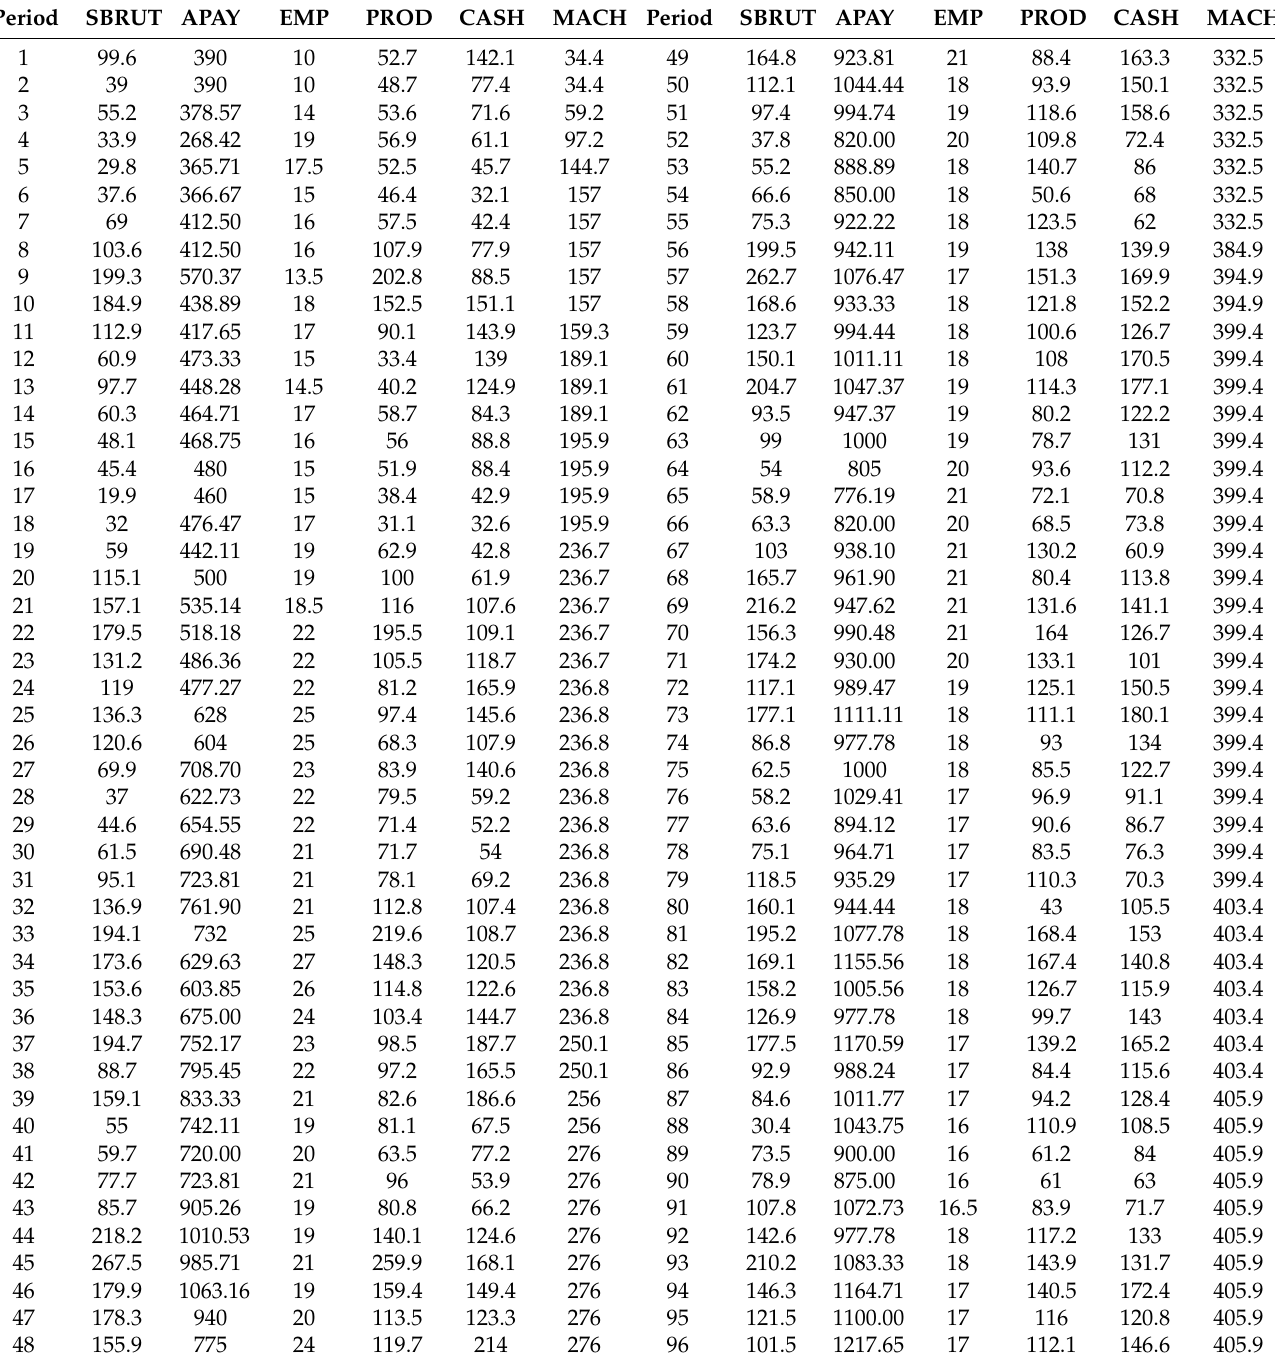
Table A6. Statistical information on the model’s variables, monthly from January 2000 to December